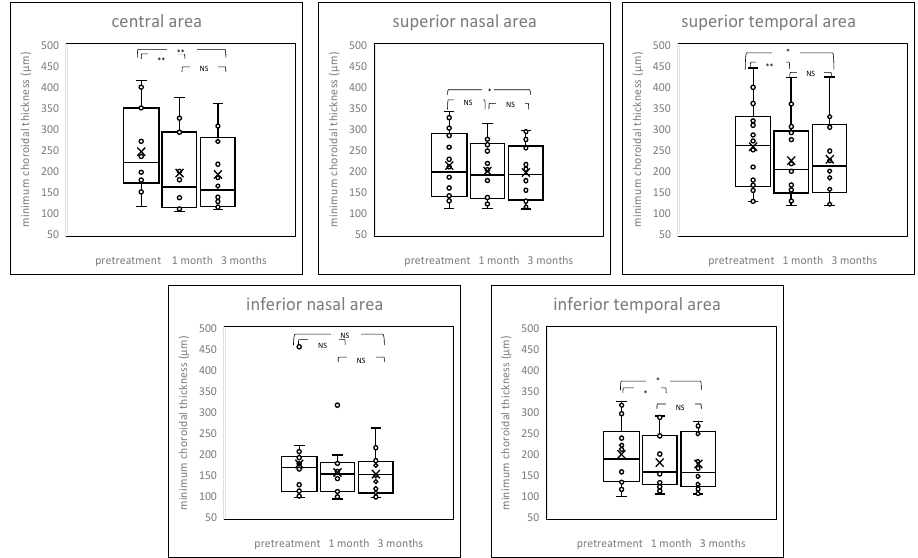
Figure 4. Box-plot graphs of minimum choroidal thickness before and after treatment. The post treatment minimum choroidal thickness showed significant reduction from baseline at central area, superior temporal, and inferior temporal areas one month after the PDT. NS = not significant, * p < 0.05, ** p < 0.01.